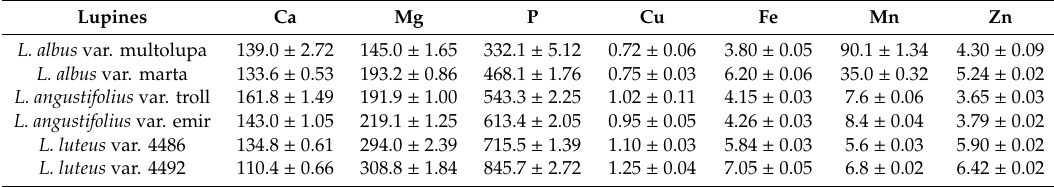
Table 3. Mineral Composition of Lupin Seed Flours (mg / 100 g of Dry Matter).